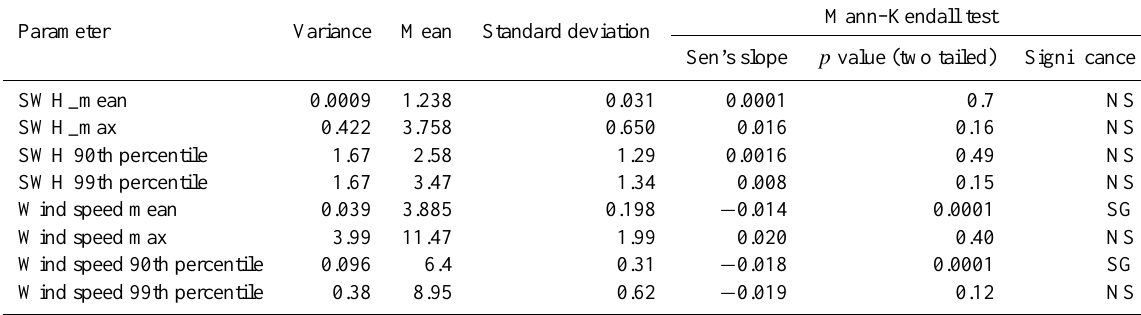
Table 4. Mann–Kendall significance test for trend